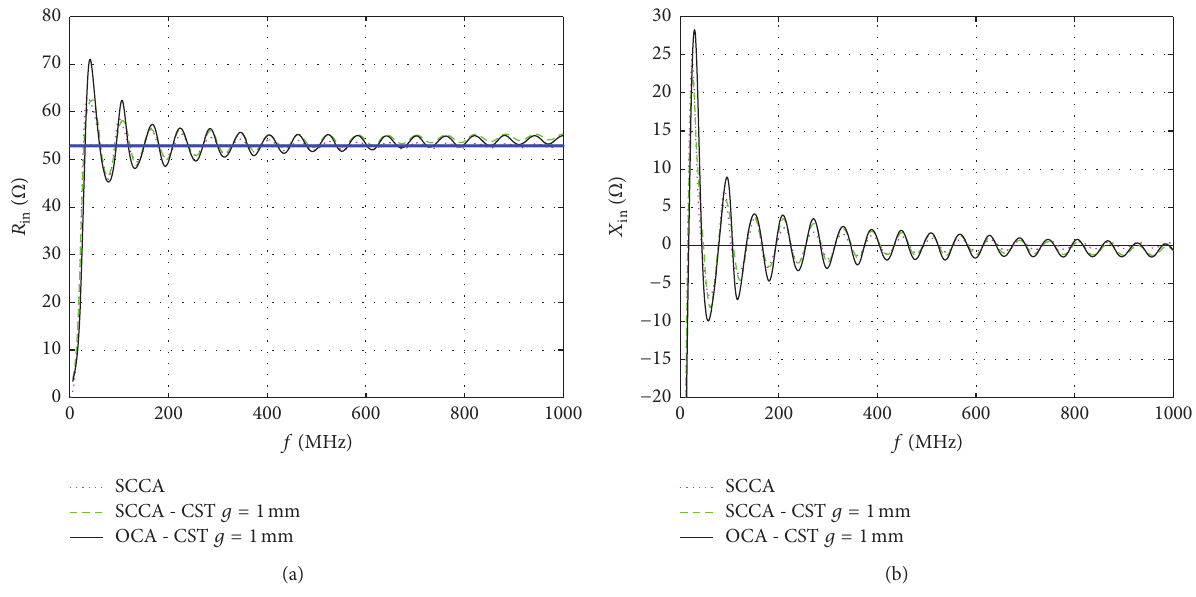
Figure 12: 𝑍 of the theoretical SCCA and the CST simulated SCCA and OCA for 𝜃 0 = 45 ∘ : (a) 𝑅 in